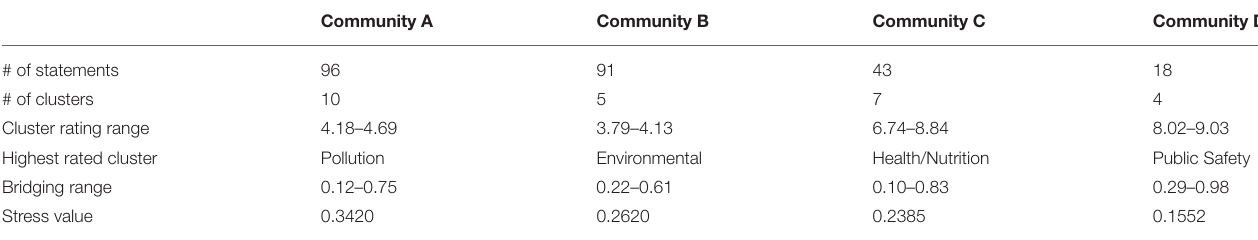
TABLE 4 | Final concept map